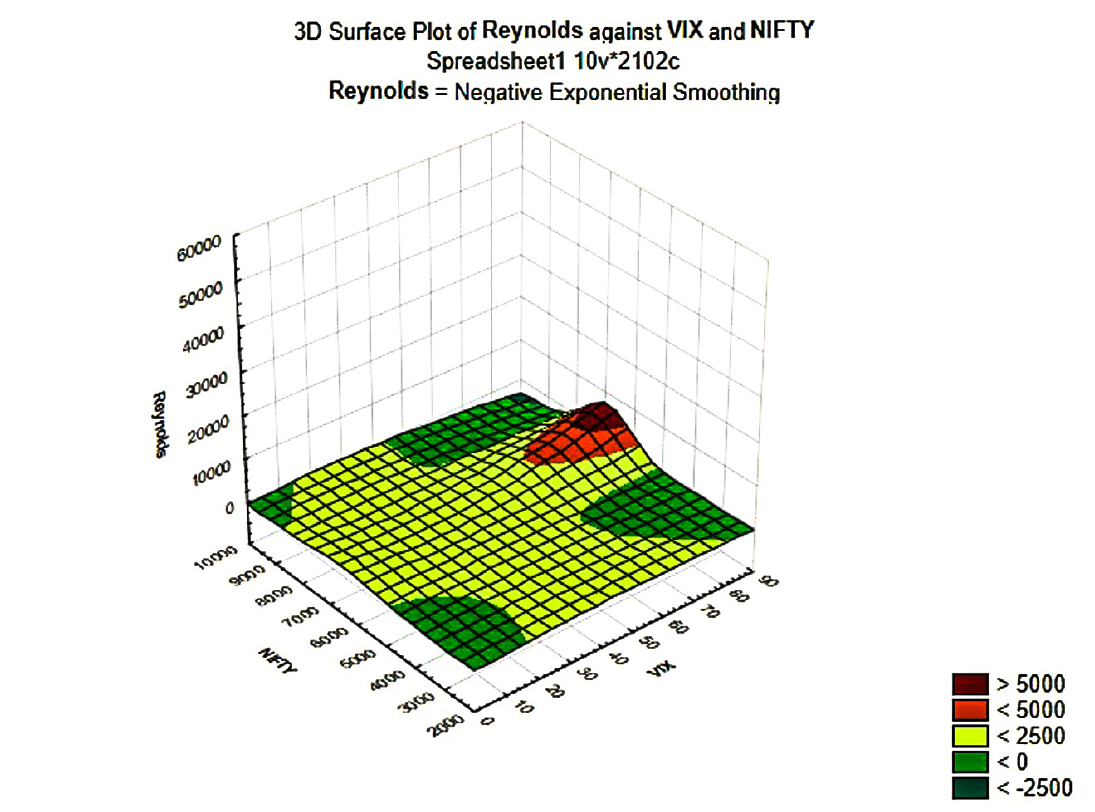
Figure 3. The Reynolds number is plotted with CNX Nifty and the volatility indicator CBOE VIX in the second and third zone combined (2007 to 2015); local minimum is observed at higher levels of CNX